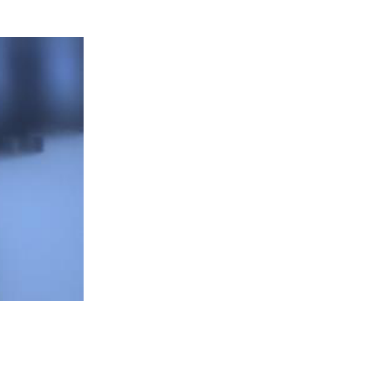
( b ) ( c ) Figure 20. Comparison chart of the forced states with different force feedback thresholds. ( a ) Comparison of radial forces at different force feedback thresholds in the first assembly experiment;